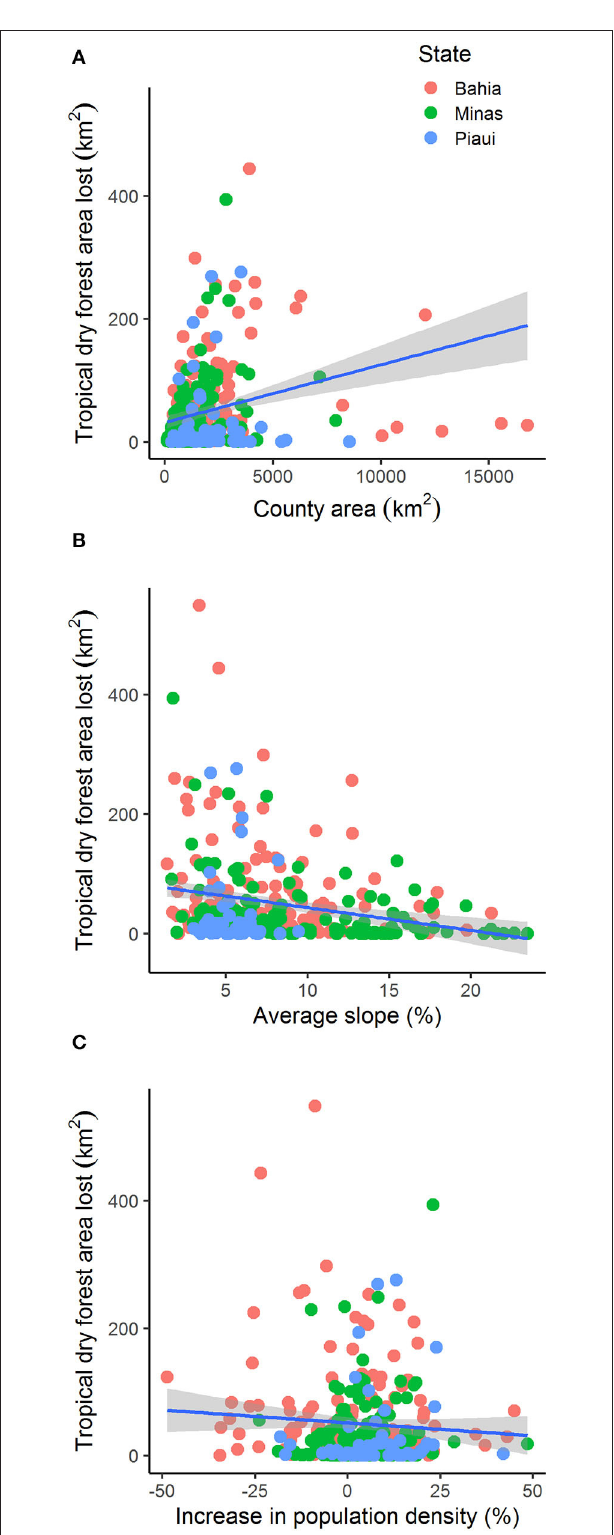
FIGURE 5 | Effects of the (A) county area, (B) average slope, and (C) increase in population density (%) on tropical dry forest area lost (km 2 ) at county level for three Brazilian states. These explanatory variables were retained in the